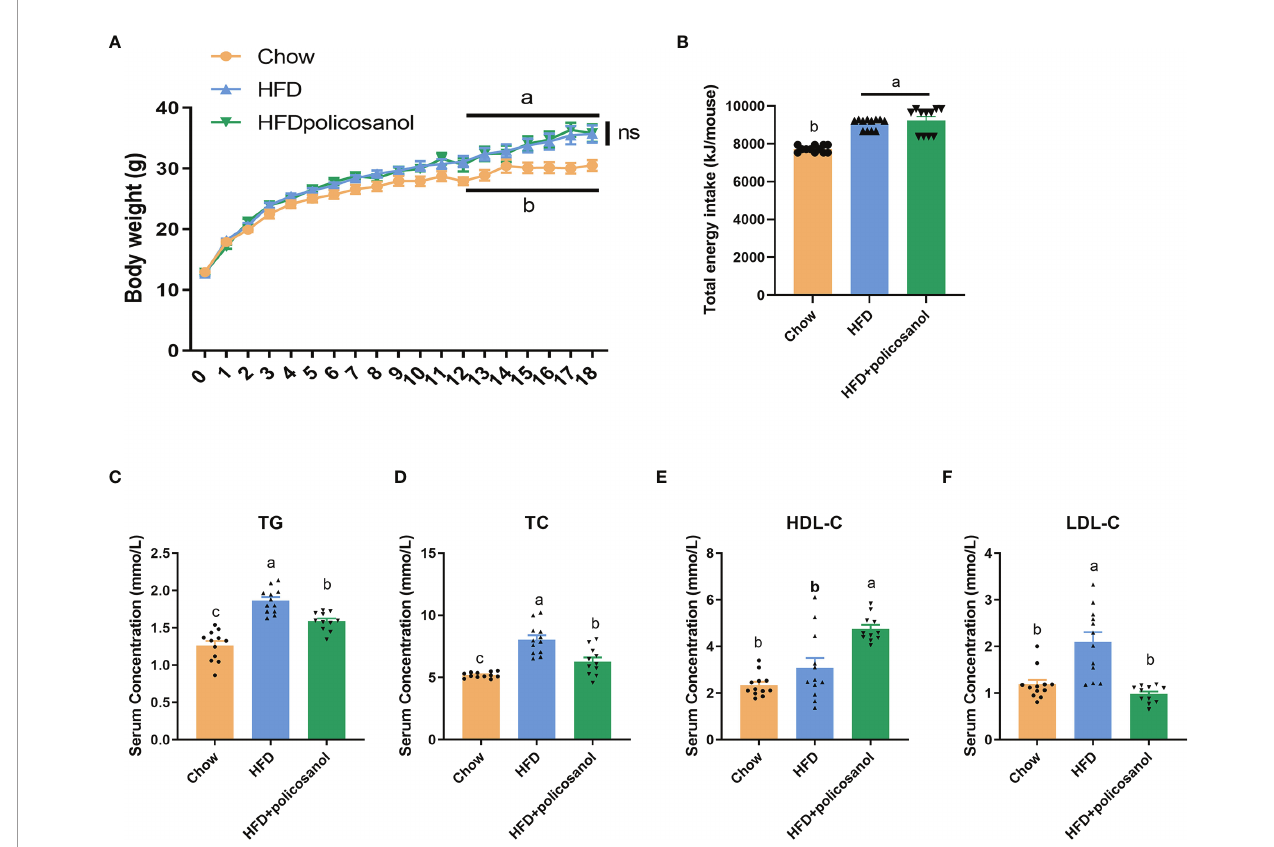
FIGURE 1 | Policosanol did not affect body weight, but showed the lipid lowering effect in the serum of mice. (A) Policosanol had no effect on the body weight of obese mice for 18 weeks. (B) The total energy intake (per mice) of chow diet or HFD fed mice after 18 weeks. (C – F) Policosanol reduced serum TG, TC, LDL-C, HDL-C in HFD induce obese mice for 18 weeks. Chow: The mice fed with chow diet (n=12), HFD: the mice fed with high fat diet (n=12), HFD+policosanol: The mice fed with high fat diet containing 0.5% policosanol (n=11). TG, Total glyceride; TC, total cholesterol; LDL-C, low density lipoprotein cholesterol; HDLC, high density lipoprotein cholesterol. Data were expressed as mean ± SEM. Differences of data in mice subjects were assessed by one-way ANOVA. For all pictures, columns indicated with different letters (a- c) have signi fi cant difference, p < 0.05. ns, not signi fi